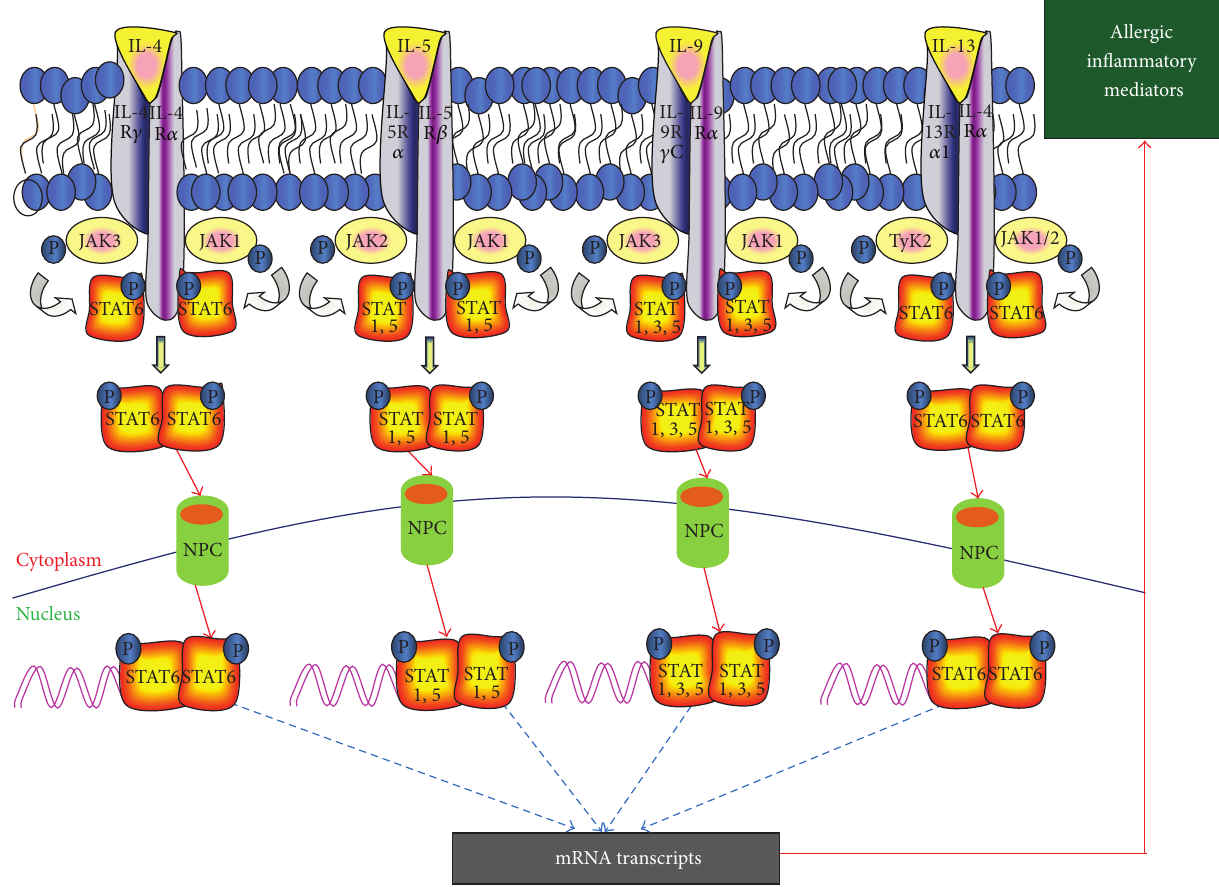
Figure 2: Schematic diagram showing the involvement of transcriptional factors in response to key mediators of allergic inflammation: binding of Th2 cytokines to their specific receptors and the activation of the downstream JAK/STAT pathways specific to each cytokine are shown. JAK: Janus activated kinase; NPC: nuclear pore complex; STAT: signal transducer and activator of transcription; TyK2: tyrosine